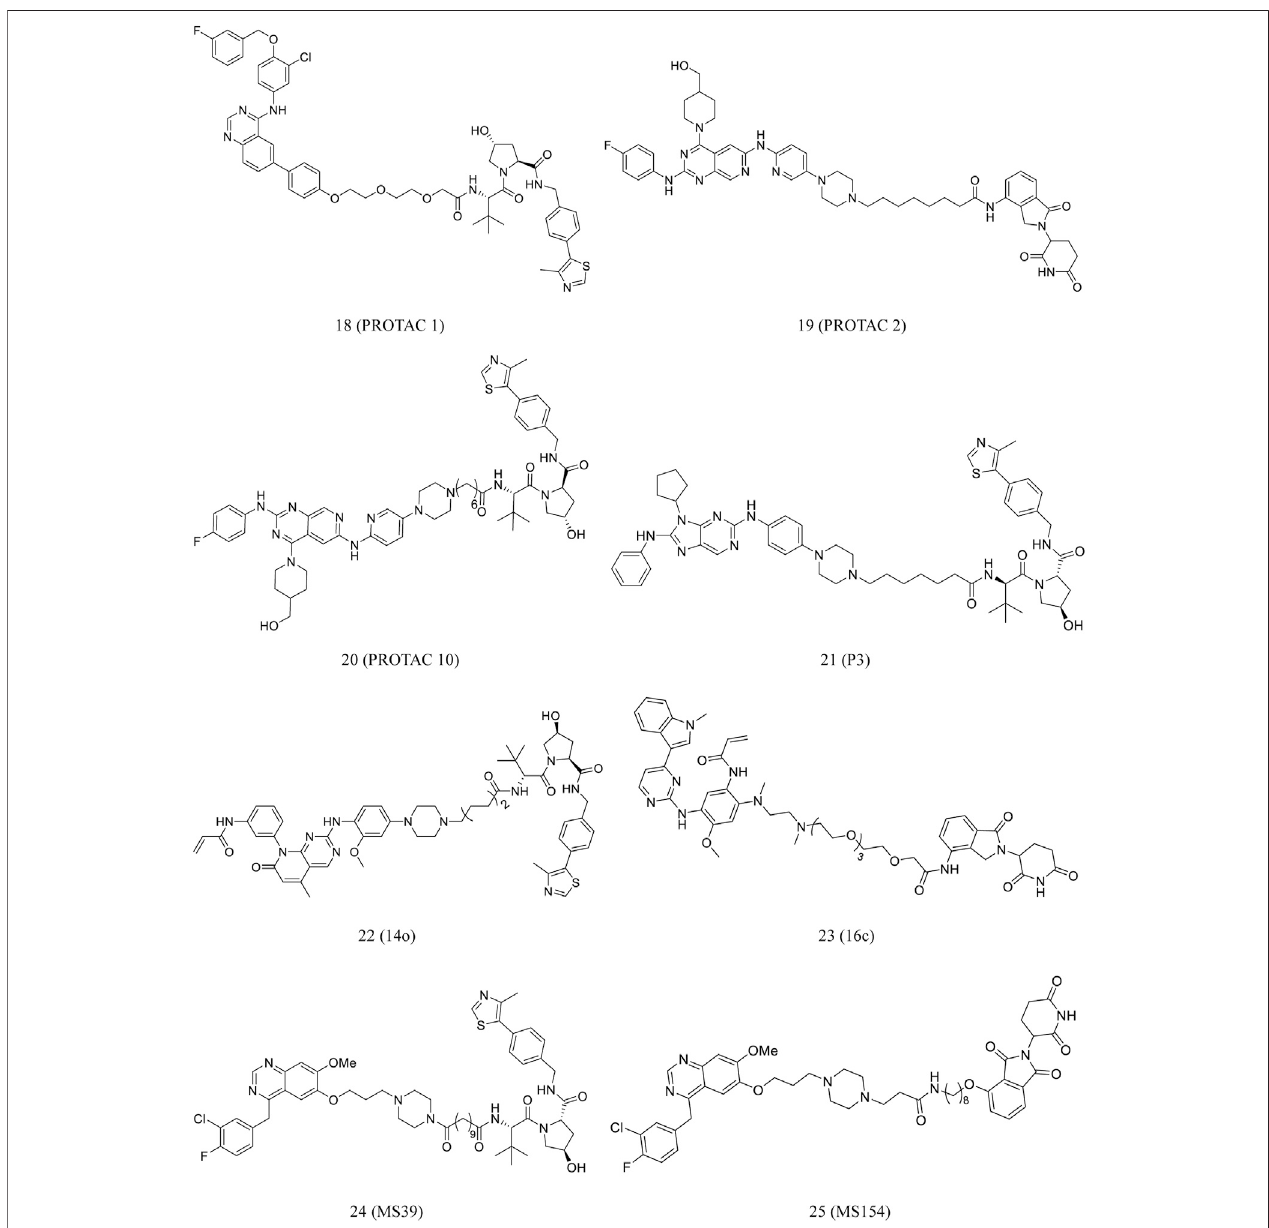
FIGURE 5 | Chemical structures of PROTACs targeting